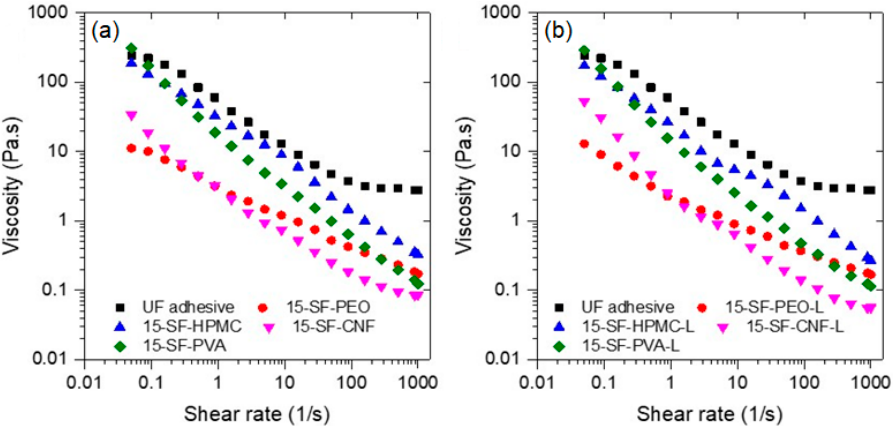
Figure 5. Flow rheology of studied adhesive soy flour formulations ( a ) without and ( b ) with lignin.